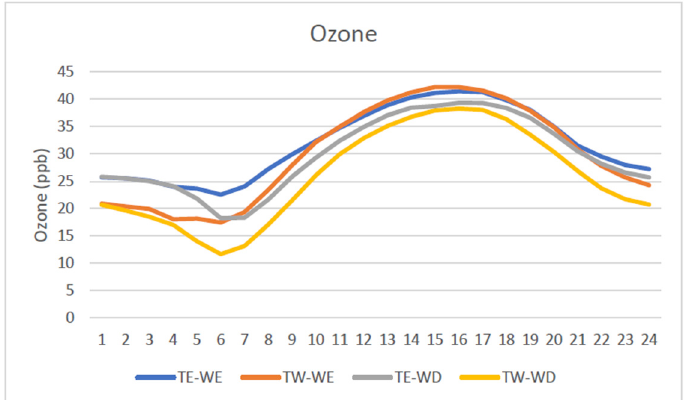
Figure 4. Ozone concentration (ppb) during the baseline period (2010–2019) for Toronto West (TW) and Toronto East (TE) for weekends (WE) and weekdays (WD).